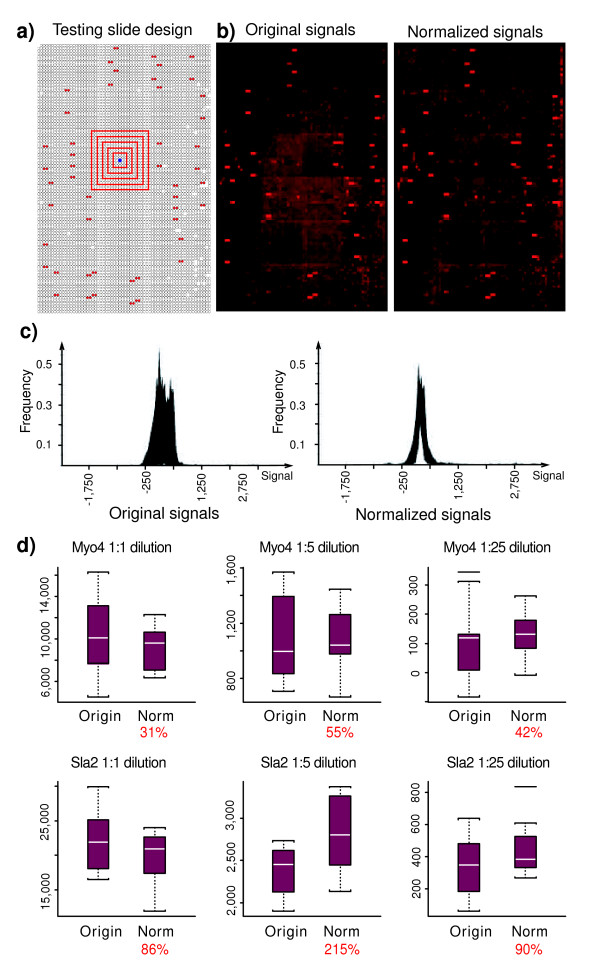
Testing experiment for the signal scaling approach. (a) The design of the test slide with positive spots shown as red spots and the five tested normalization window, indicated by red squares, for a given spot on the array, shown in blue. (b) Comparison of signal intensity before and after normalization using window size 9 on the testing experiment. The two images were computationally reconstructed from the signal files, either without or with normalization. (c) Density plots of signals in the local windows are shown superimposed. The distributions are more similar to each other after the signal normalization using the default window size 9. (d) Variation analysis for positive controls. Five out of six controls showed a decrease of variances after normalization.